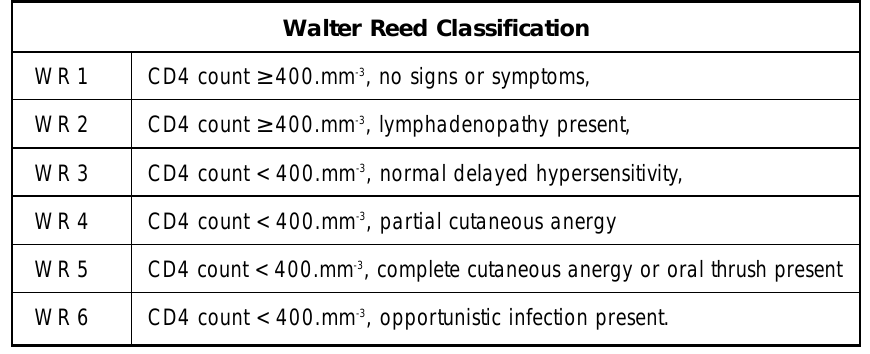
Table 1: Walter Reed Classification.